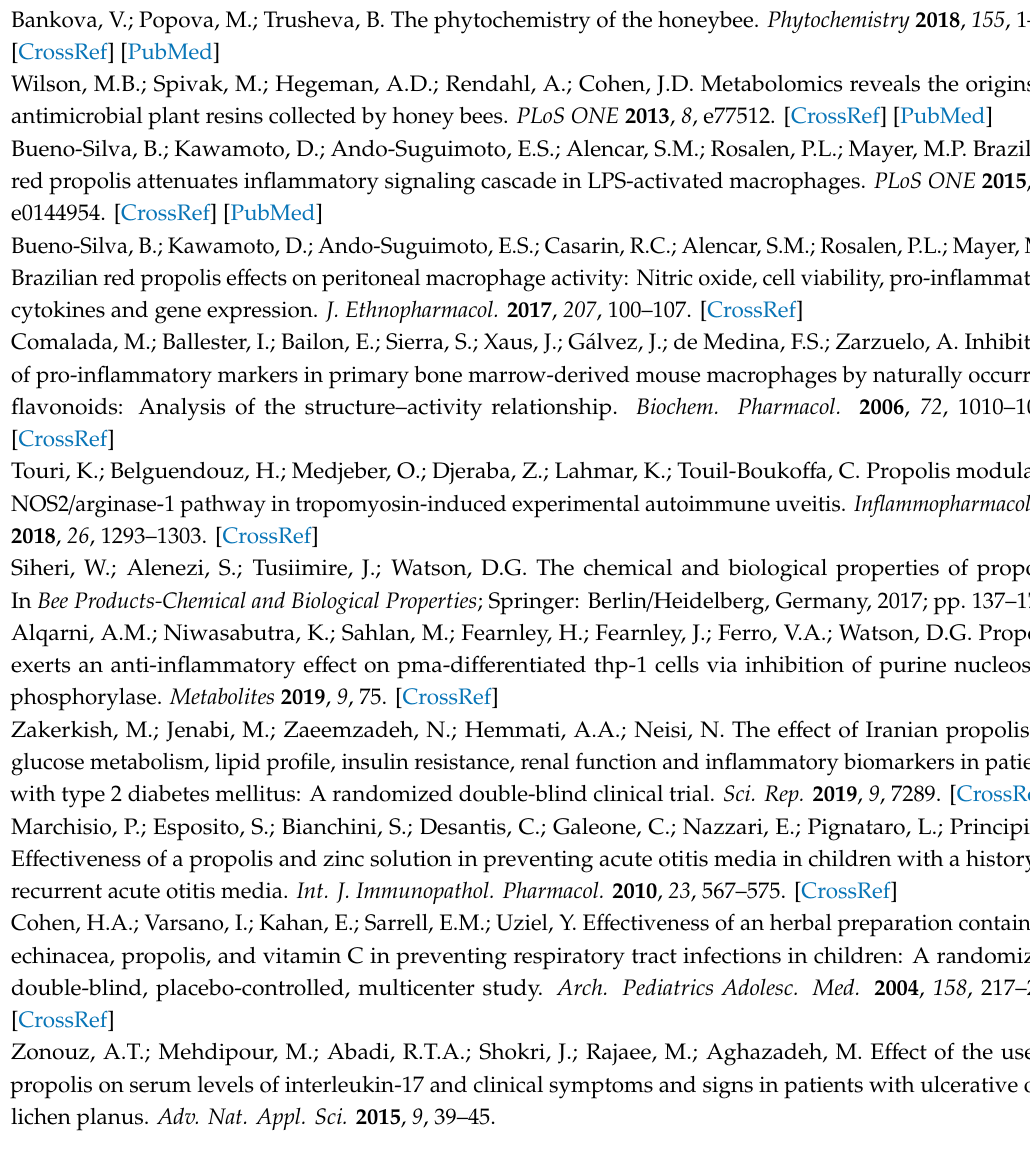
Figure S1: Extracted ion traces for chrysin in samples 225 and 224, Figure S2: Extracted ion traces for pinocembrin in samples 225 and 224, Figure S3: Extracted ion traces for galangin in samples 225 and 224, Figure S4: Extracted ion traces for pinobanksin in samples 225 and 224, Figure S5: Extracted ion traces for galangin methyl ethers in samples 225 and 224, Figure S6: Extracted ion traces for kaempferol in samples 225 and 224, Appendix 1: PDF file including mean peak areas and associated SEM values for the features extracted from the raw data